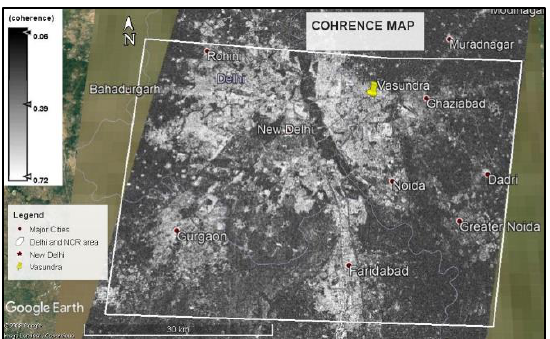
Figure 3 coherence image of NCR overlapped on google earth image to show major cities in rectangle and pin point area is